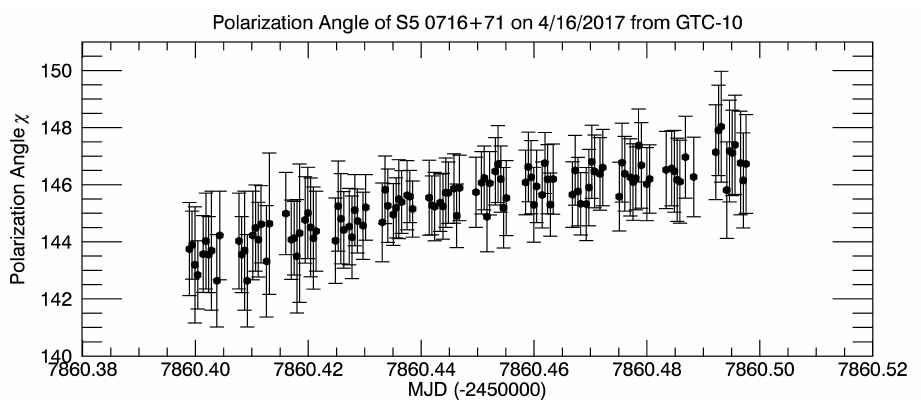
Figure 6. H-band polarization angle from CIRCE observations. The rise in angle may be due to an elevation angle effect as there wasn’t sufficient time to calibrate for the